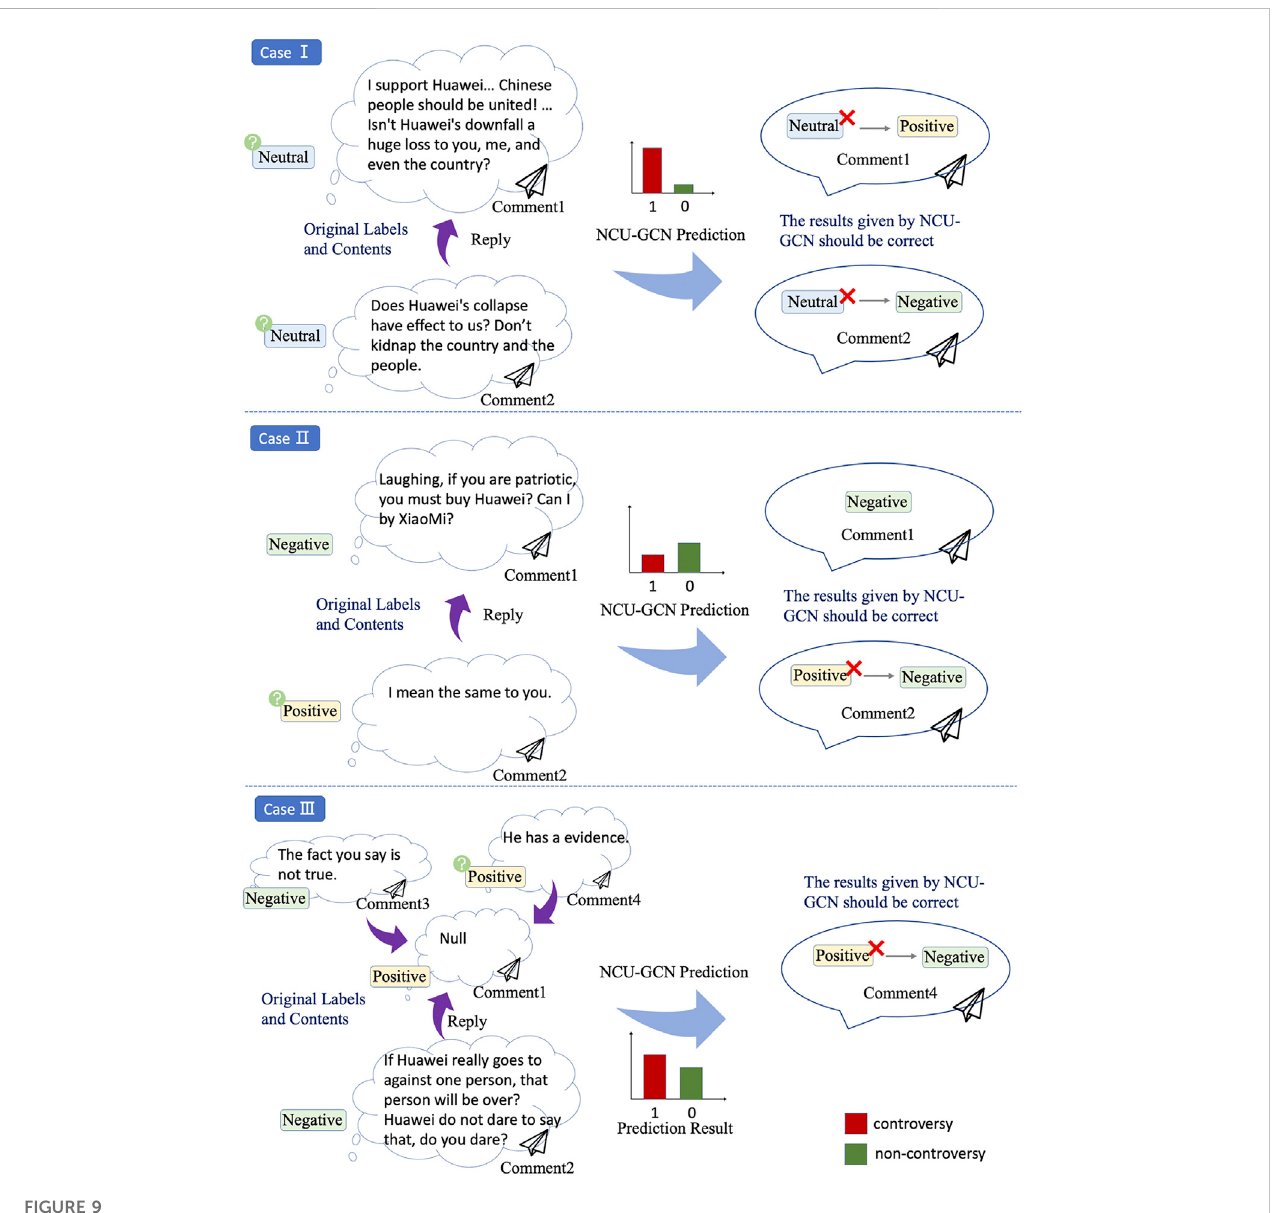
FIGURE 9 Samples of the comments which may get a wrong